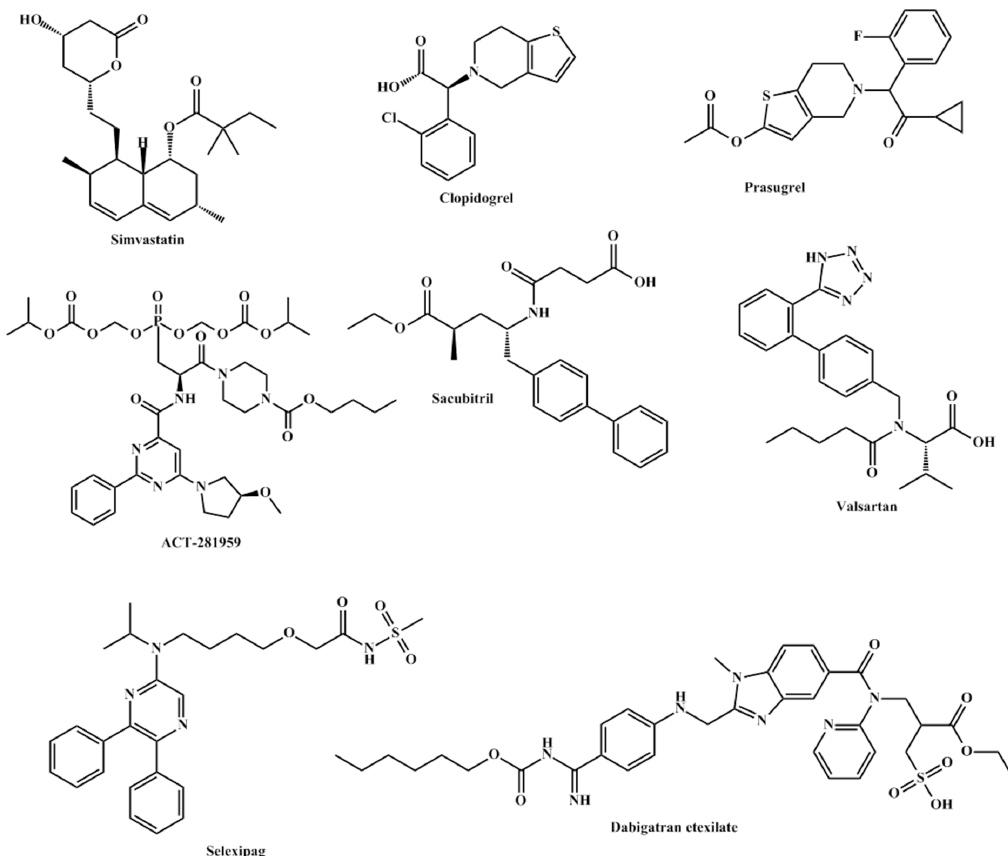
Figure 1. Structures of prodrugs reported in this sub-section.